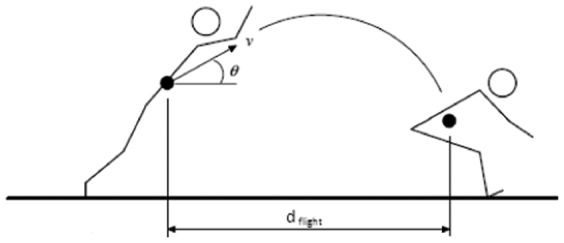
Depiction of standing horizontal jump, with key terms illustrated.v  =  take-off speed; θ  =  take-off angle, dflight  =  horizontal distance moved by the centre of mass of the body, hf  =  flight height (adapted from Wakai and Linthorne, 2005).